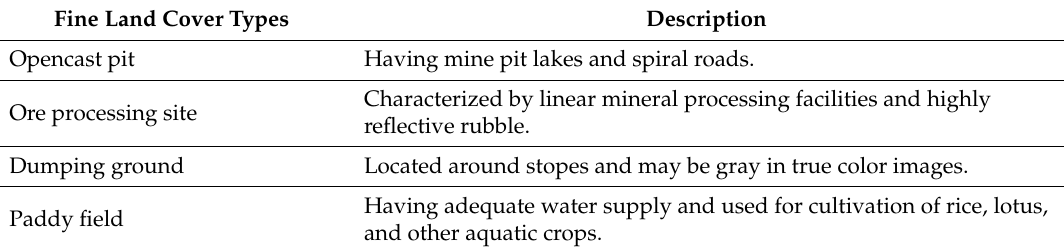
Table 3. Land cover classification schemes used in this study (revised from